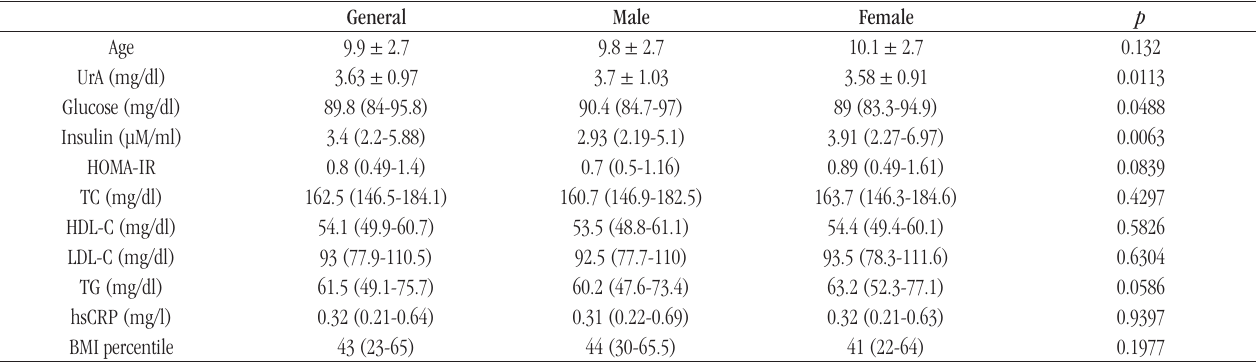
taBLE 1 − Biodemographic and laboratorial characteristics of 623 eutrophic students a